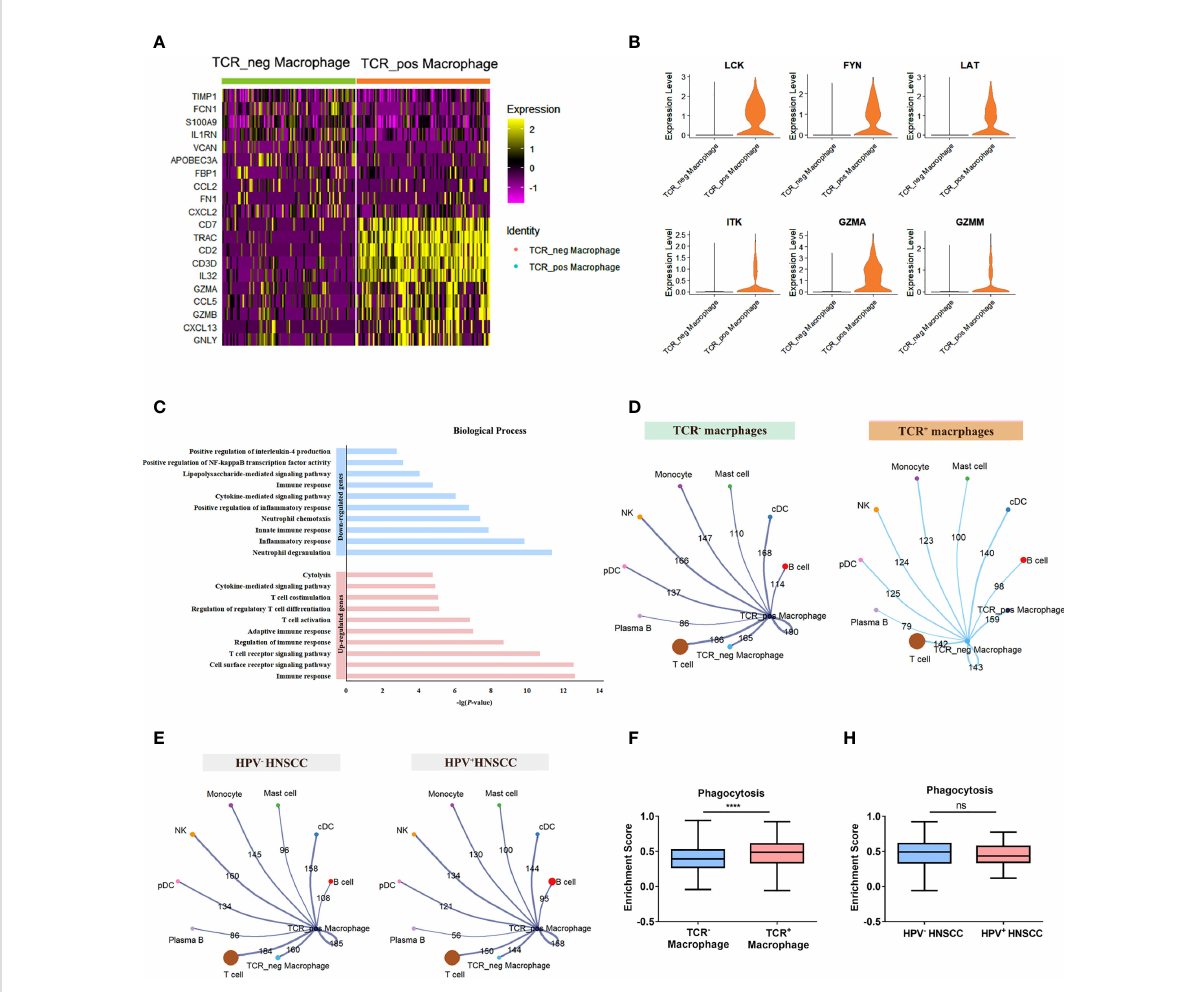
FIGURE 5 Differences between TCR + macrophages and TCR - macrophages. (A) The heatmap of the fi rst 10 genes differentially expressed in TCR +/- macrophages. (B) Functional enrichment of upregulated genes and downregulated genes in TCR + macrophages. (C) UMAP plot of different genes in TCR + macrophages and TCR - macrophages. (D) The aggregated cell – cell communication analysis of TCR + and TCR - macrophages in HNSCC by CellChat. (E) The aggregated cell – cell communication analysis of TCR + macrophages in HPV +/- HNSCC by CellChat. (F) Comparisons of the phagocytosis score of TCR +/- macrophages in HNSCCs **** P < 0.0001. (H) Comparisons of the phagocytosis score of TCR + macrophages between HPV +/- HNSCC